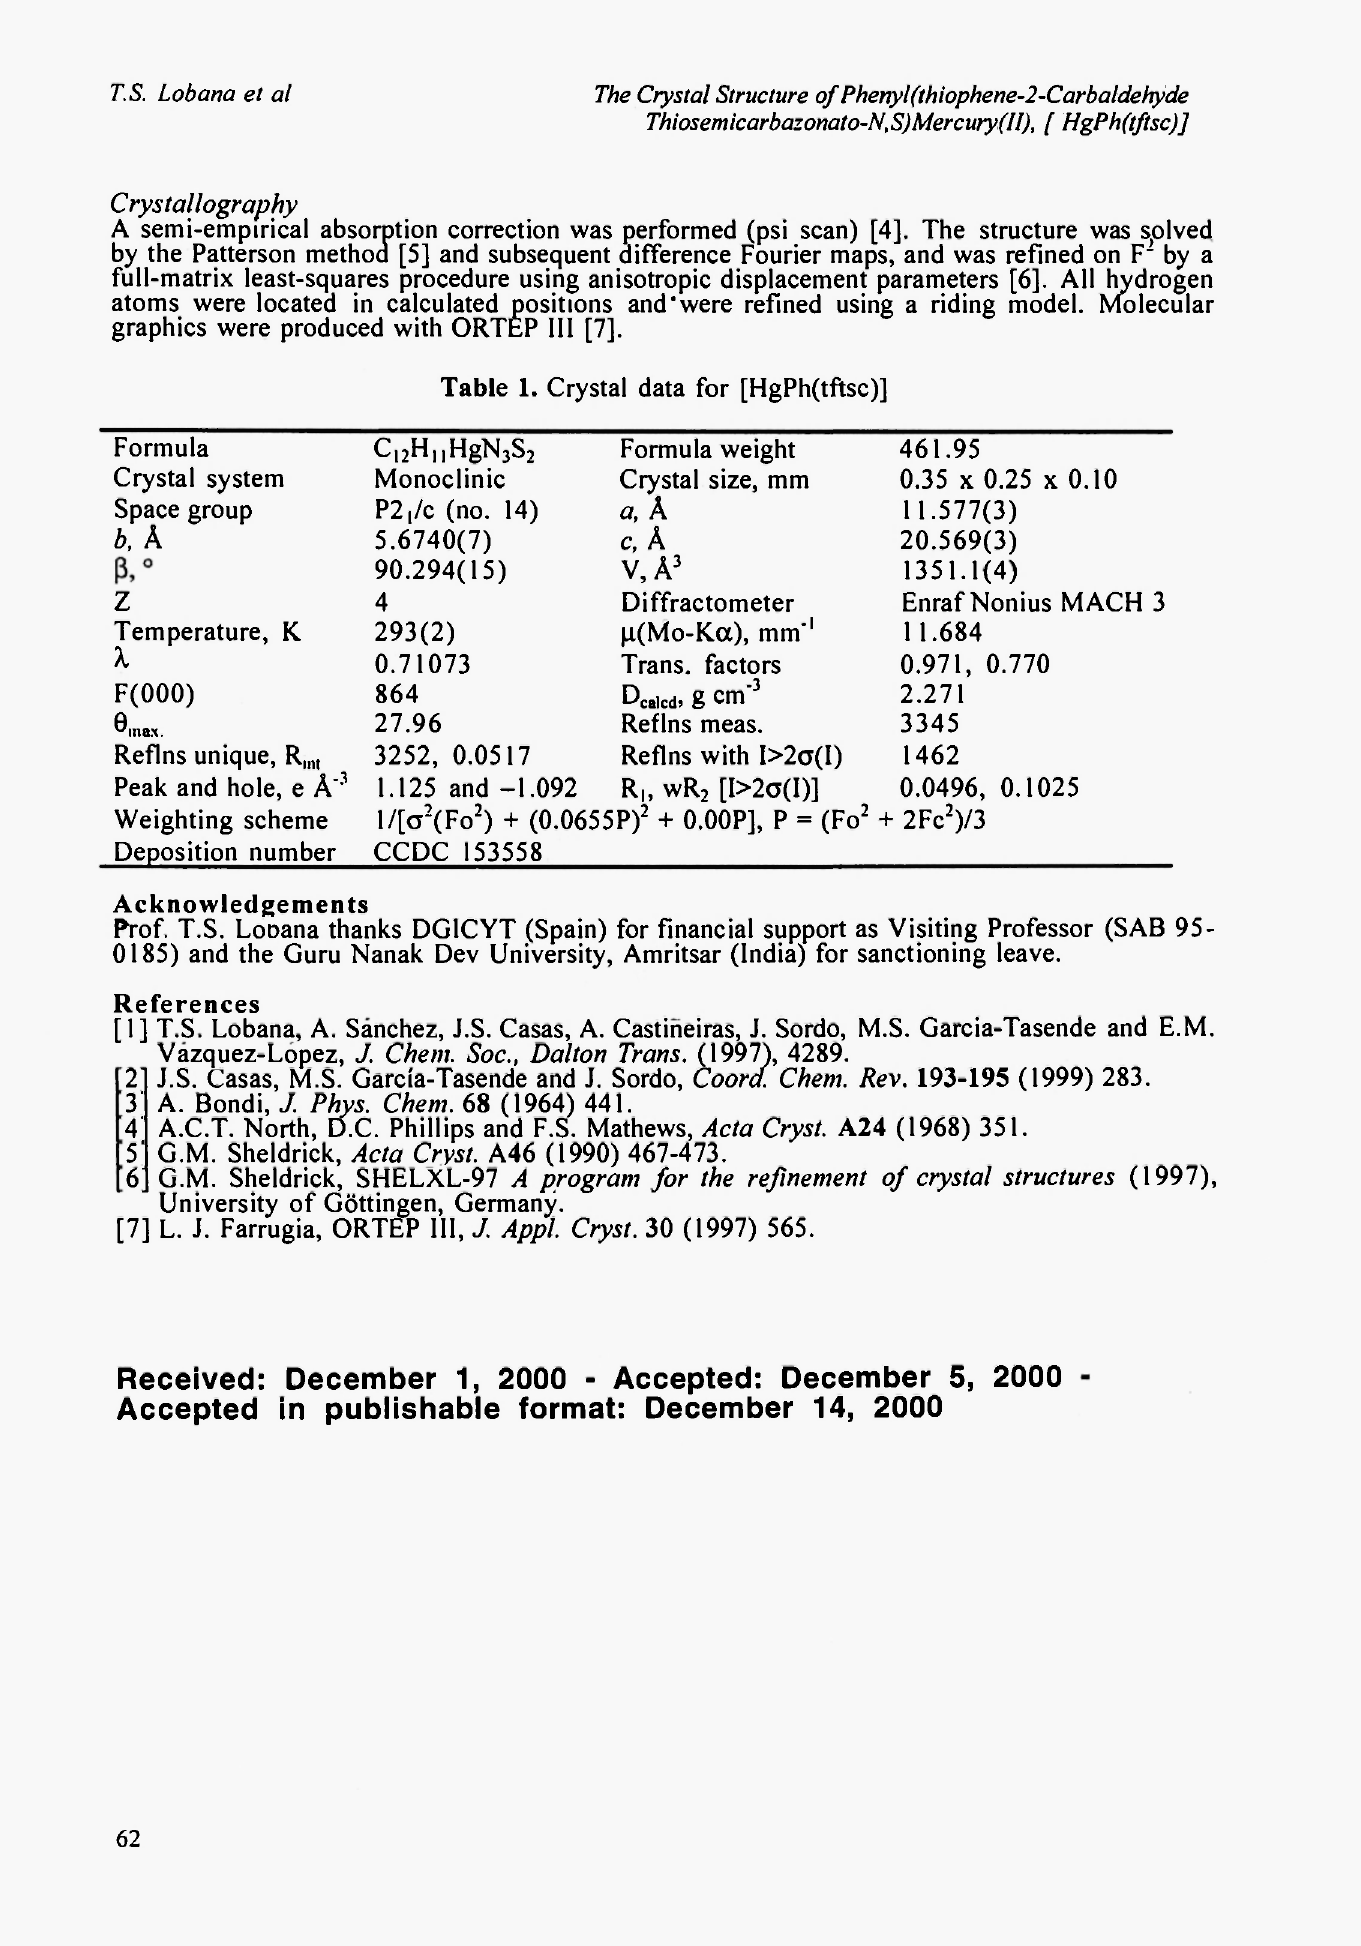
Table 1. Crystal data for